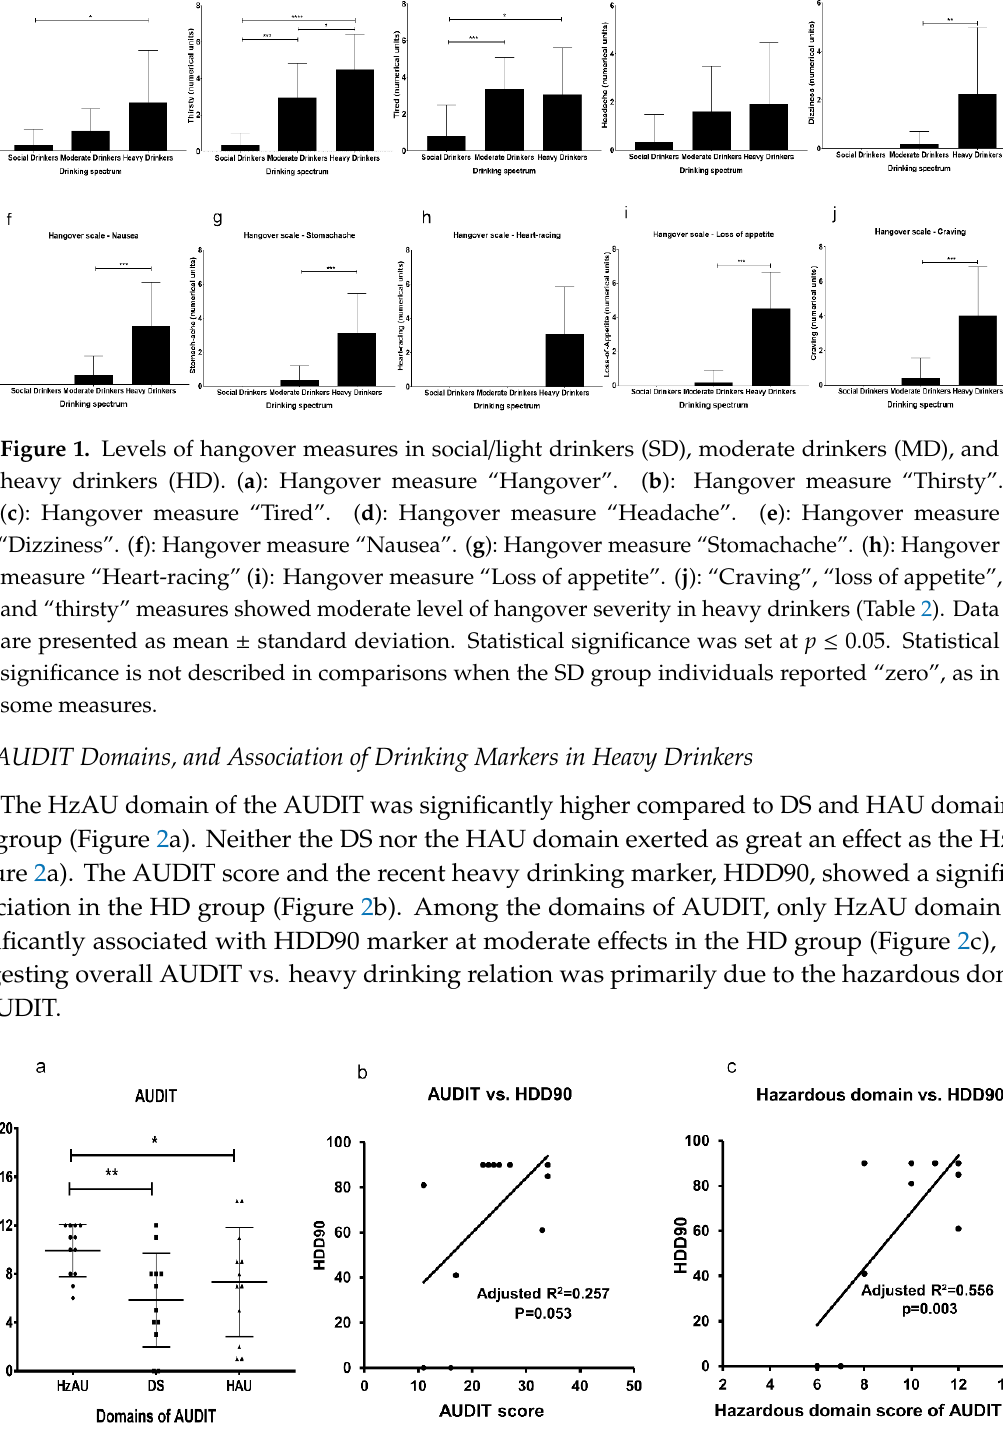
Figure 2. AUDIT and its association with timeline followback measures in heavy drinkers (HD). ( a ) Presentation of hazardous, dependency, and harmful domains that constitute AUDIT. ( b ) AUDIT score and heavy drinking days past 90 days (HDD90) drinking marker. ( c ) Scores of “hazardous- domain” of AUDIT and HDD90 (There are two points each for 11 and 12 [hazardous domain] that have corresponding 90 units of HDD90). Statistical significance was set at p ≤